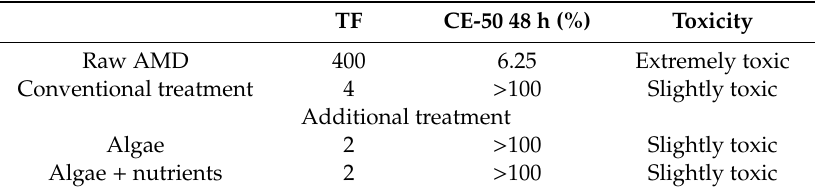
Table 3. Toxicity assays for Daphnia Magna microcrustaceans exposed to raw AMD; AMD after conventional treatment; and AMD after additional treatment with algae, with and without nutrients addition. TF CE-50 48 h (%) Toxicity Raw AMD 400 6.25 Extremely toxic Conventional treatment 4 > 100 Slightly toxic Additional treatment Algae 2 > 100 Slightly toxic Algae + nutrients 2 >